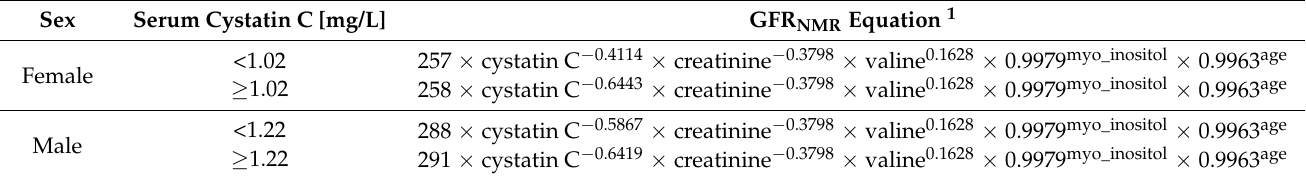
Table 2. GFR NMR equation according to serum cystatin C cutoff levels and